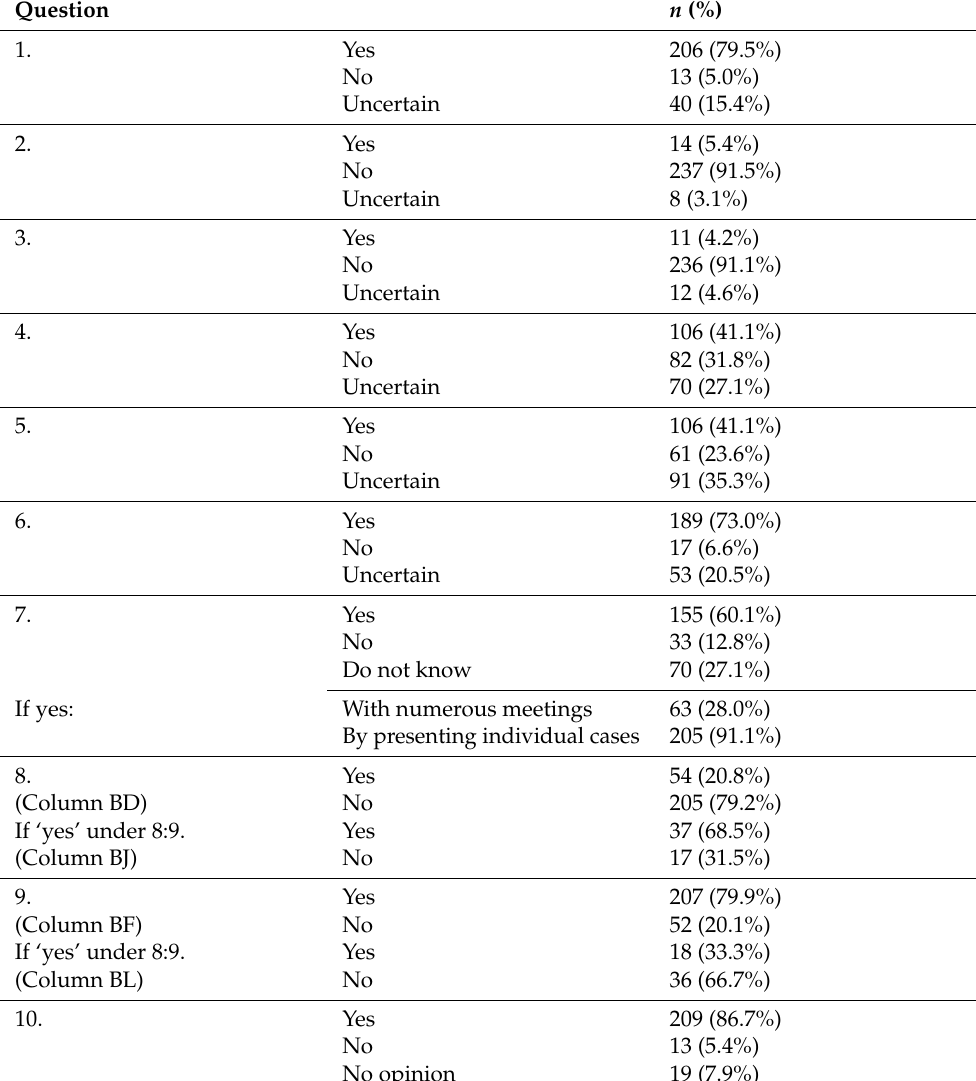
Table 5. Questions on professional exchange in the field of rare diseases with orofacial participation (Section